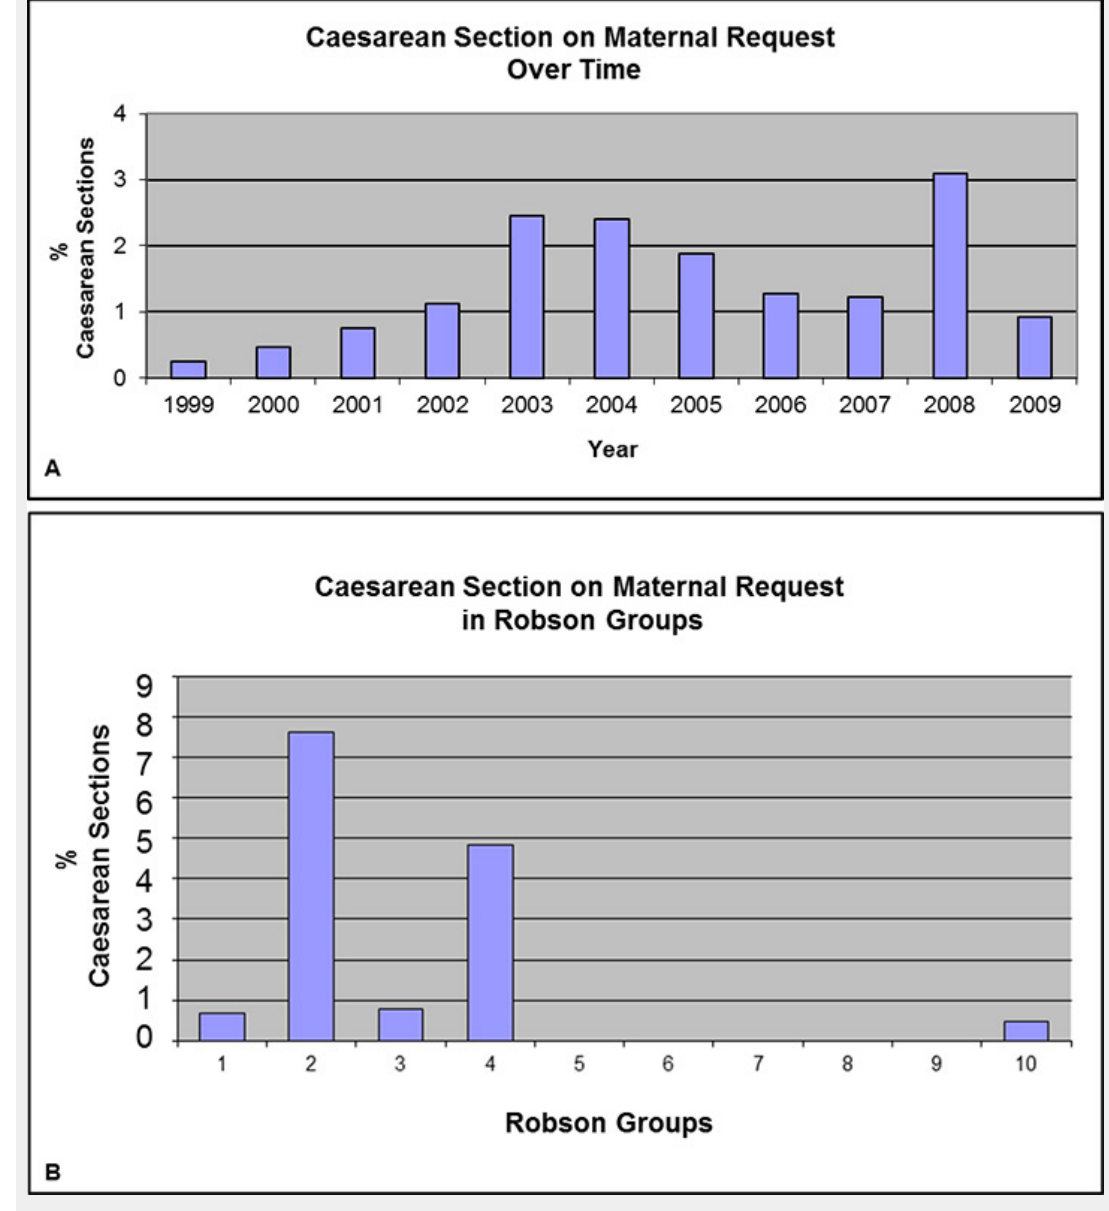
A: Temporal change of the caesarean section on maternal request (CSMR) rate in the observation period of time. The mean CSMR was 1.45% and a significant increase was detected (p = 0.008). B: Caesarean section on maternal request in different Robson groups in the observation period of time. Groups 2 and 4 (woman with single cephalic pregnancy ≥37 weeks gestation with induced labour or CS before labour) displayed the highest CSMR rates (7.6% and 4.8%,